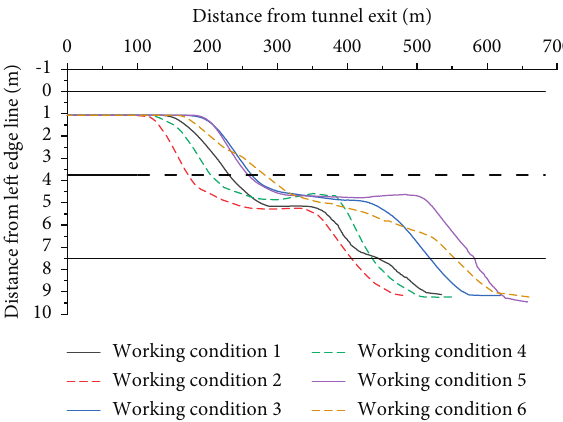
Figure 5: Vehicle trajectories under different working conditions of the second service level.